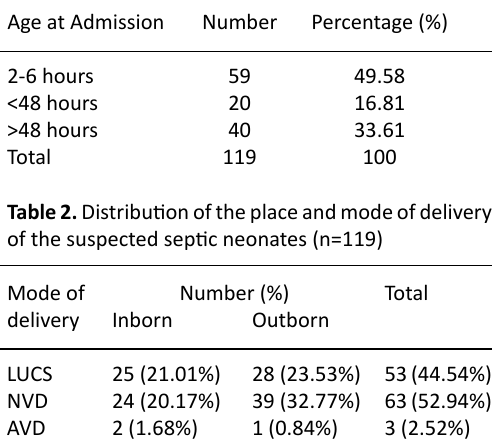
Table 1. Distribution of age of new born at time of admission to SNCU with symptoms (n=119)